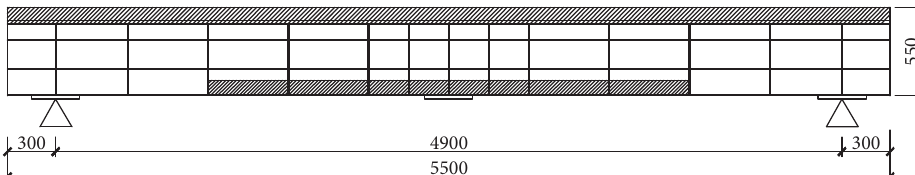
Figure 2: Longitudinal section of test beam (unit: mm).